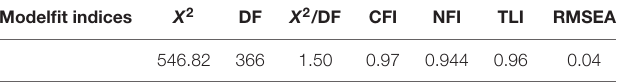
TABLE 3 | Reliability and convergent validity.